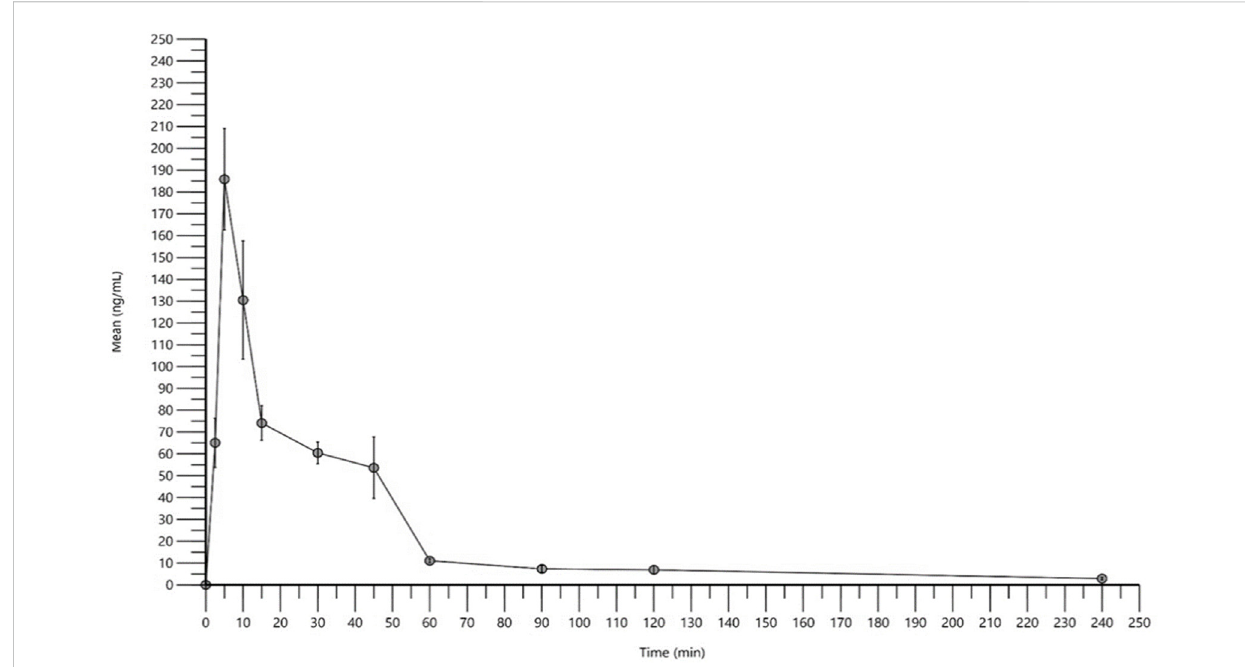
FIGURE 6 2 ′ -hydroxy fl avanone (2HF) pharmacokinetic pro fi le. Blood concentration versus time. BALB/c mice were orally treated with 10 mg/kg of 2HF. Mousebloodwascollected via theorbitalplexusfordetectionandquanti fi cationbythevalidated2HFmethodthroughHPLC – MS/MS.Thevaluesplotted on the graph are the mean and standard error ( n =